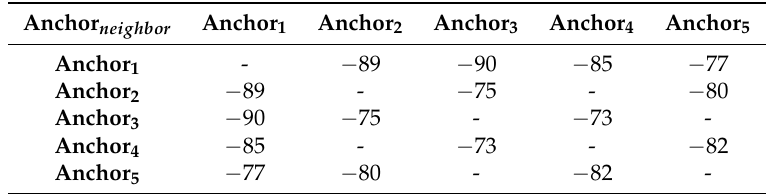
Figure 2. Real distances among anchor nodes. Table 1. RSSI values between anchor nodes. Gathered by physically positioning a mobile node near an anchor node and sending packets that will be received by all other nearby anchors. This step is repeated for all anchor nodes in the